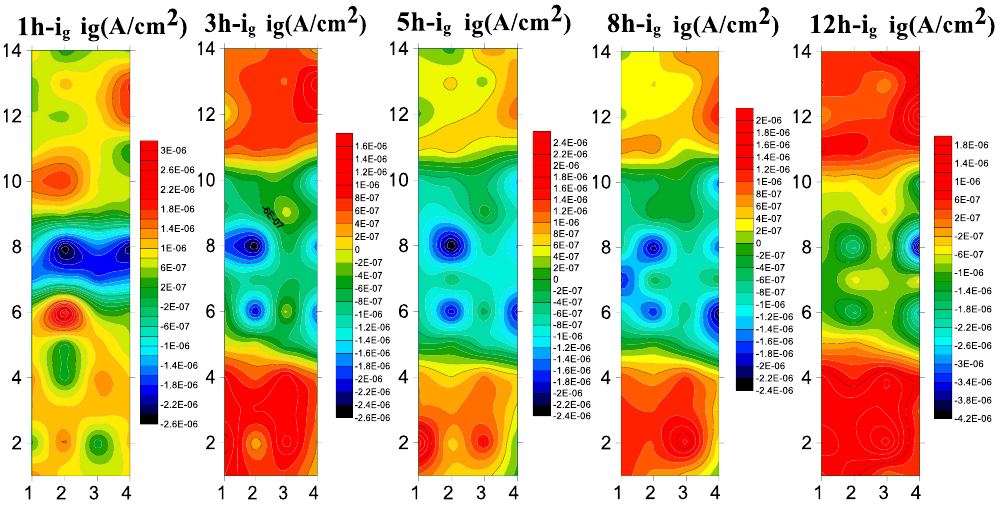
Figure 17. The array electrode test results of B10 alloy welded joint area at 6 m/s.